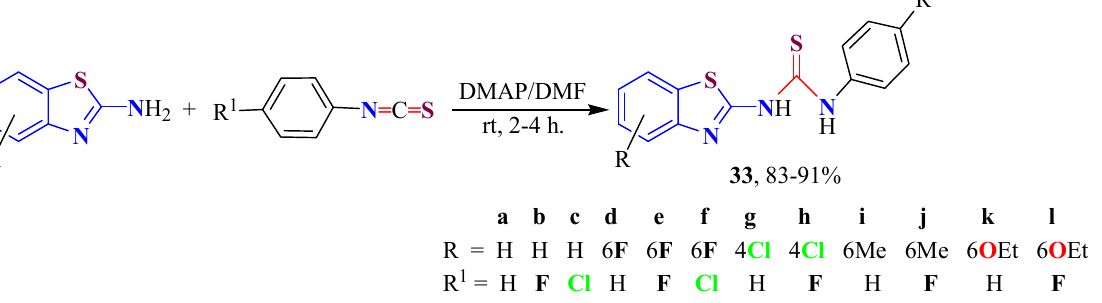
Figure 6. The 4/6-arylsubstituted-TBTs from 4/6-substituted 2ABT and aryl isothiocyanates. Azam and coworkers synthetized aryl-UBT derivatives 34a – s from the reaction